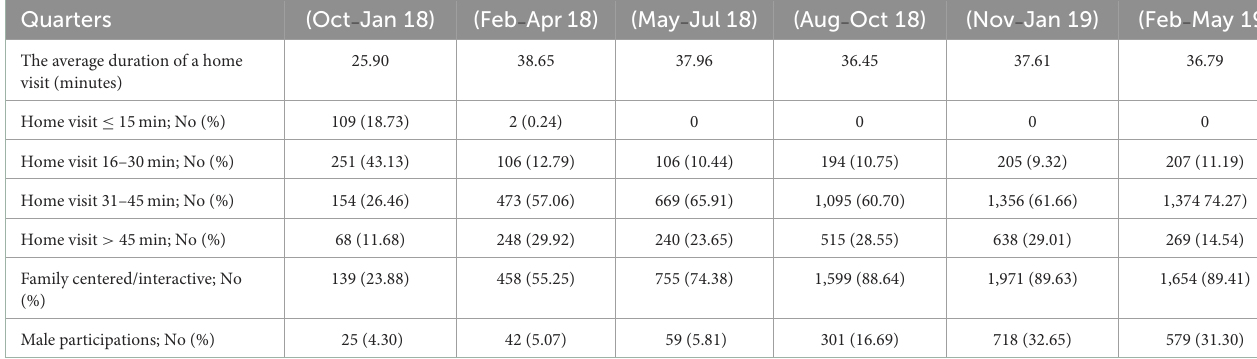
TABLE 3 Indicators on intervention delivery by the service provider with the review